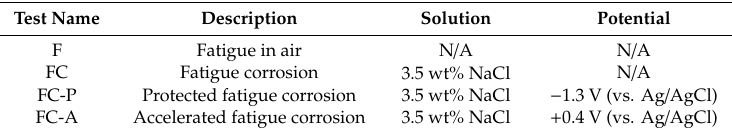
Table 2. Testing parameters of fatigue tests.